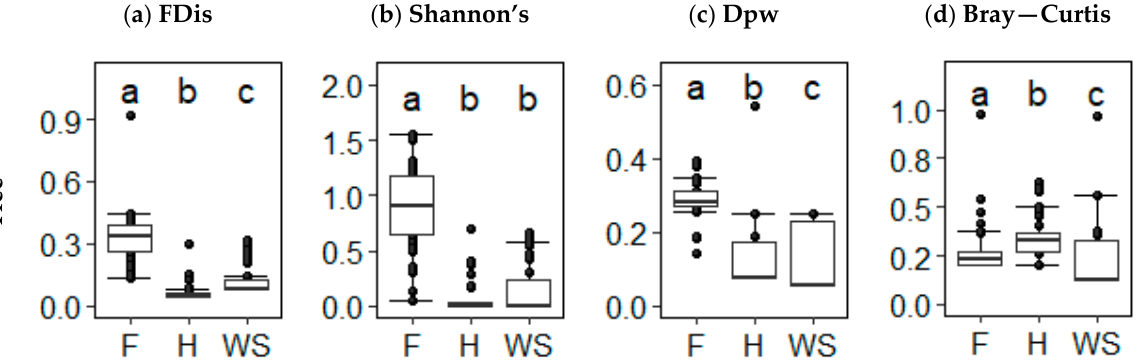
Figure 4. ( a ) Functional alpha diversity (functional dispersion), ( b ) taxonomic alpha diversity (Shannon’s diversity), ( c ) functional beta diversity (functional pairwise dissimilarity), and ( d ) taxonomic beta diversity (Bray–Curtis dissimilarity) values for trees in forest (F) ( n = 40), heath (H) ( n = 45), and shrub savannah (SS) ( n = 45) alternate states. Unlike letters above the error bars indicate significant differences at p < 0.05.